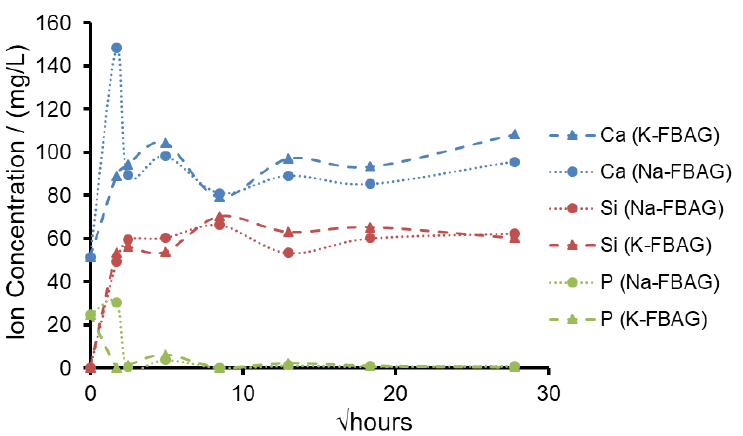
Figure 10. Concentration of Ca (blue), Si (red) and P (green) after immersion in AS7 Na-FBAG (circle) and K-FBAG (triangle) for up to 4 weeks.